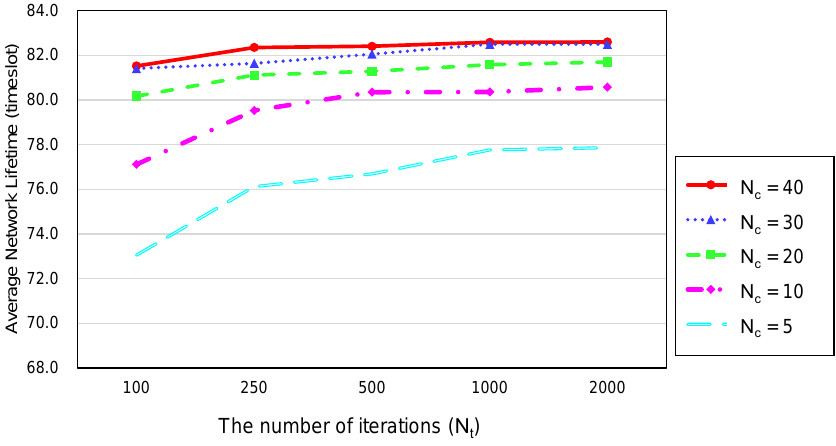
Figure 6. Average network lifetime against N c and N t